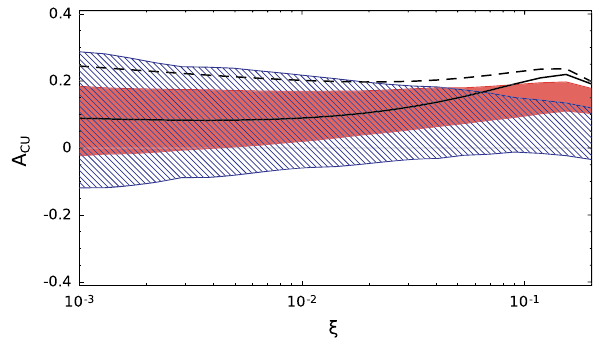
Fig. 6 Circular asymmetry A CU evaluated with LO and NLO spacelike-to-timelike relations for Q (cid:4) 2 = 4 GeV 2 , t = − 0 . 1 GeV 2 and E γ = 10 GeV as a function of φ . The cross sections used to evalu- ate the asymmetry are integrated over θ ∈ (π/ 4 , 3 π/ 4 ) . For the further description see the caption of Fig. 2